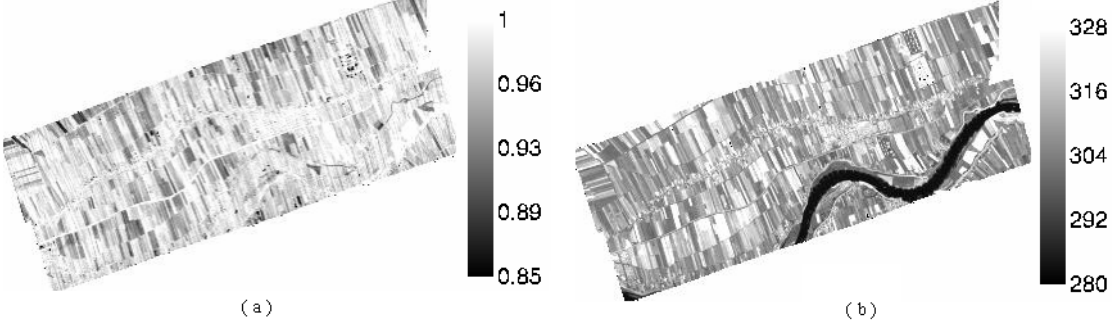
Figure 1. Retrieval of land surface emissivity and temperature (K) of HJ-1B from simulated AHS data, (a) land surface emissivity, (b) land surface